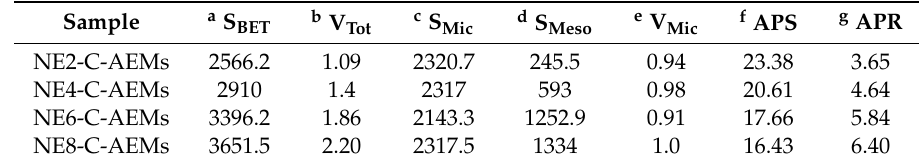
Table 1. Textural properties of